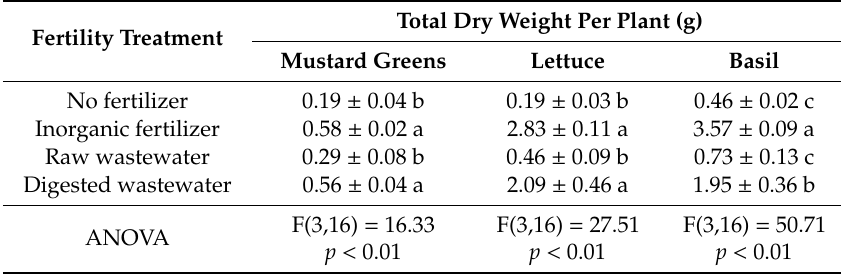
Table 1. Mean ± SE total above-ground biomass, or per plant dry weight (g), for mustard greens, lettuce, and basil grown with di ff erent fertility treatments in a greenhouse in St. Paul, Minnesota in 2018. One-way ANOVA results for fertility treatments were performed on each parameter and crop. Values within the same column with di ff erent letters are significantly di ff erent (Tukey’s HSD, α = 0.05). Fertility